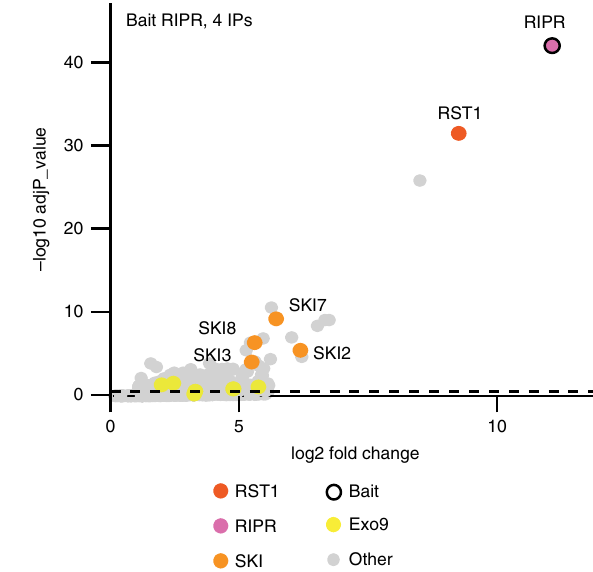
Fig. 6 RIPR co-immunoprecipitates RST1, SKI7 and the Ski complex. The Volcano plot shows the enrichment of proteins co-puri fi ed with GFP-tagged RIPR as compared with control IPs. Y - and X -axis display adjusted p -value and fold change, respectively. The dashed line indicates the threshold above which proteins are signi fi cantly enriched. The source data